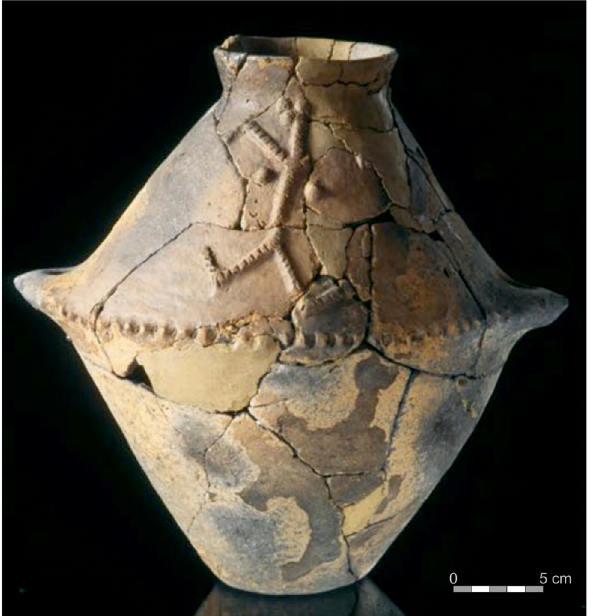
Figure 8: Amphora with anthropomorphic representation from Targowisko site 11 ( acc. to Grabowska & Zastawny, 2007 ) .